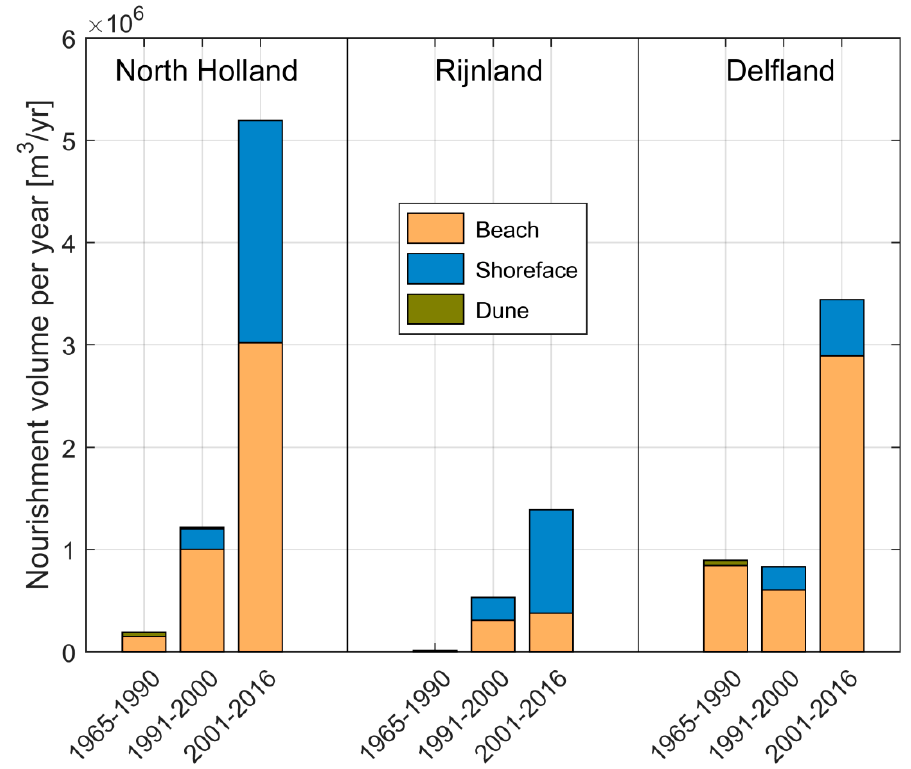
Figure 2. Nourishment volumes (millions m 3 /year) at the Holland coast for the three periods: 1965–1990, 1991–2000, and 2001–2016. Note that the North Holland coast is ≈ 55 km long, Rijnland ≈ 41 km, and Delfland ≈ 21 km.